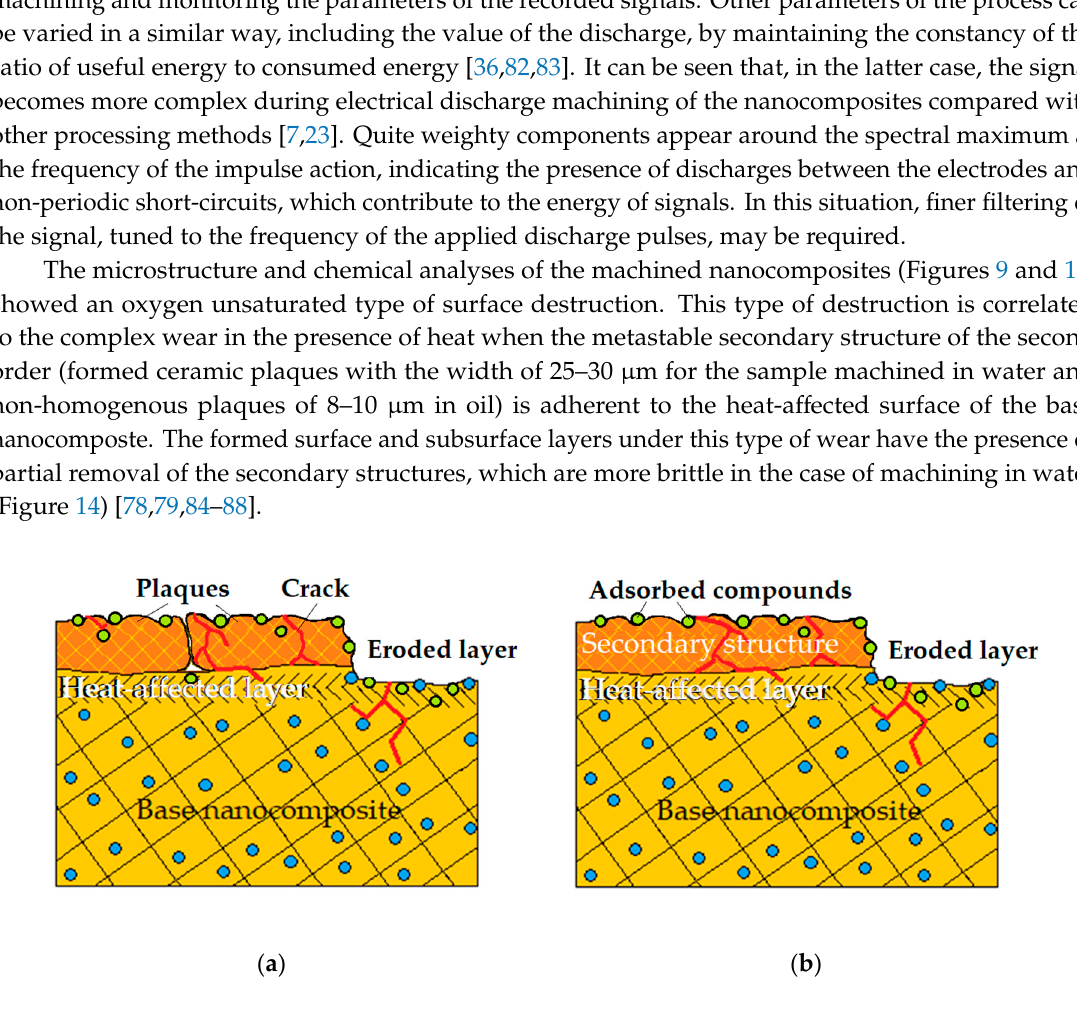
Figure 14. The submicron structure of surface and subsurface layers under the oxygen unsaturated type of destruction for ceramic nanocomposite: ( a ) in oil; ( b ) in